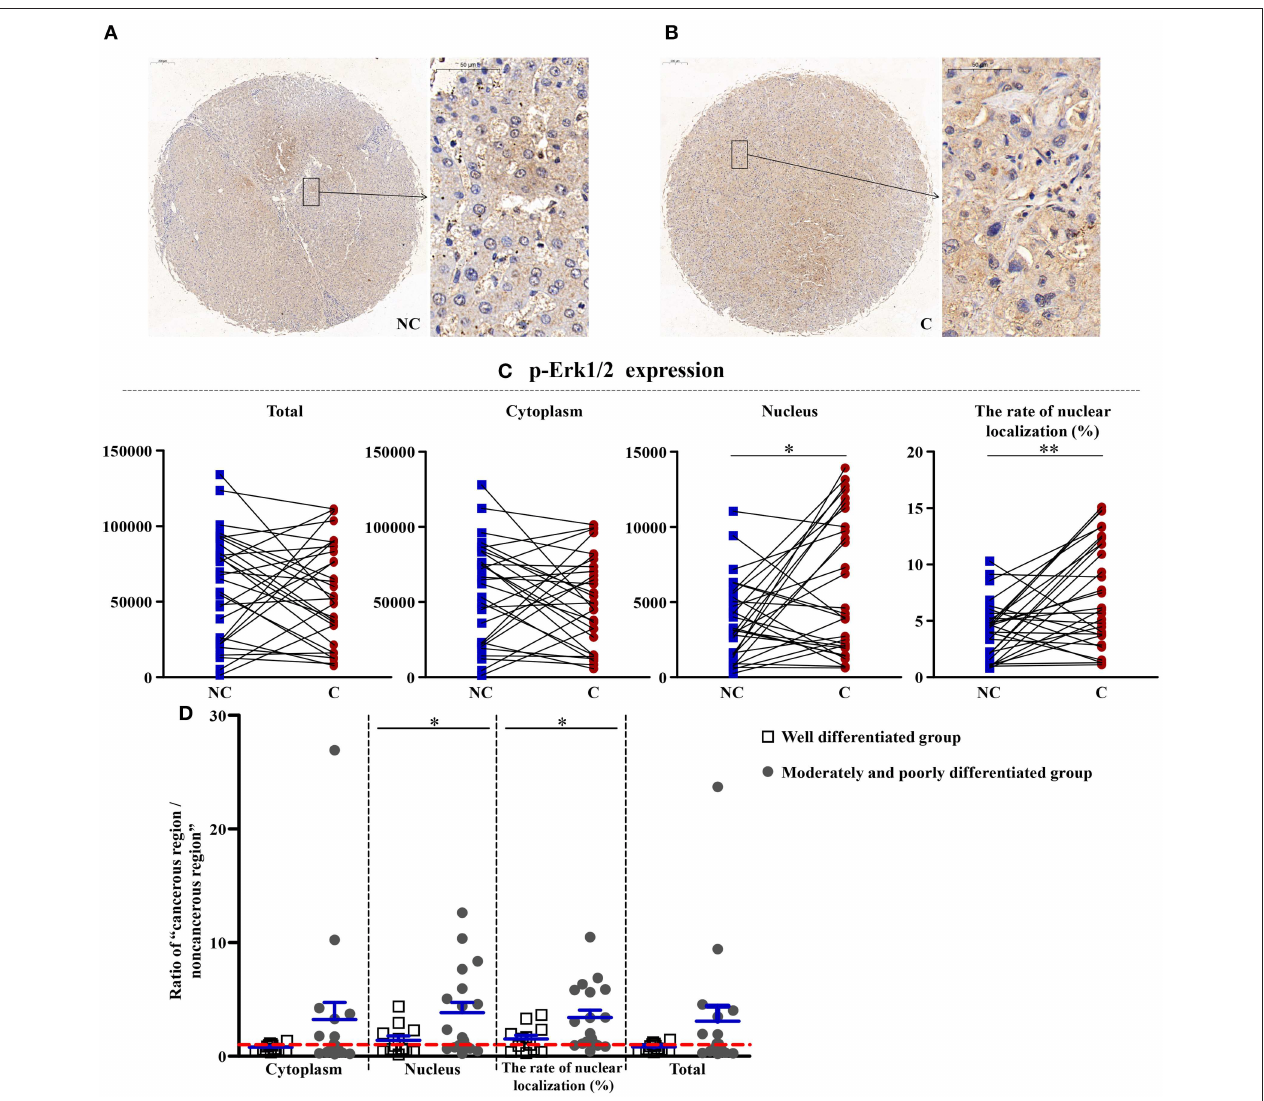
FIGURE 4 | The detailed expression of p-Erk1/2. Representative images of p-Erk1/2 protein expression in liver cancer’s corresponding (A) non-cancerous (NC) and (B) cancerous (C) regions. (C) Quantification of p-Erk1/2 expression (total, cytoplasmic, and nuclear expressions and the rate of nuclear localization) levels using multispectral image analysis in the liver cancer samples. (D) The ratio of “cancerous region/non-cancerous region” of p-Erk1/2 expression in two groups (well-differentiated group vs. moderately and poorly differentiated group). The red line indicates that the ratio is equal to 1. Scale bar: 200 or 50 µ m. * , **Denote significant differences from the noncancerous region, or well-differentiated group with P < 0.05, 0.01,